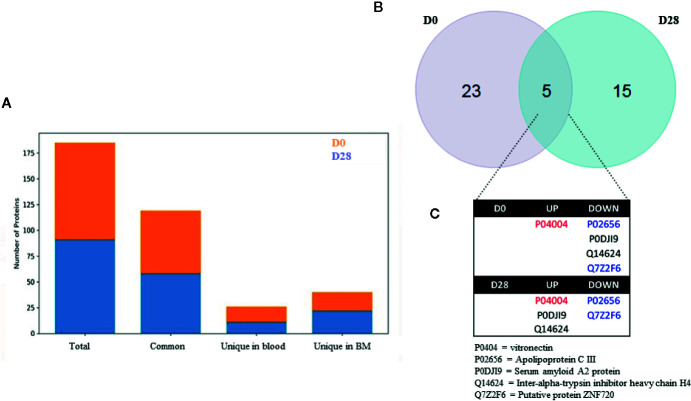
Proteomic design of the study (A) and the number of common and unique proteins identified in the high-throughput proteomic screening. In (B), Venn’s diagram from the differentially expressed proteins in our study. Up and downregulated proteins differentially expressed in peripheral blood plasma samples from ALL-B patients at D0 – at diagnosis, before treatment start, and D28 – at the end of the treatment, comparing the blood versus the bone marrow. (C) Highlight from the 5 protein differentially expressed among D0 and D28. In red: upregulated proteins in both comparisons; In blue: downregulated proteins in both comparisons; In black: proteins in which quantification shifted according to comparison to bone marrow. * Chemotherapic protocol according to the Brazilian Group for Treatment of Childhood Leukemia scheme (2009).